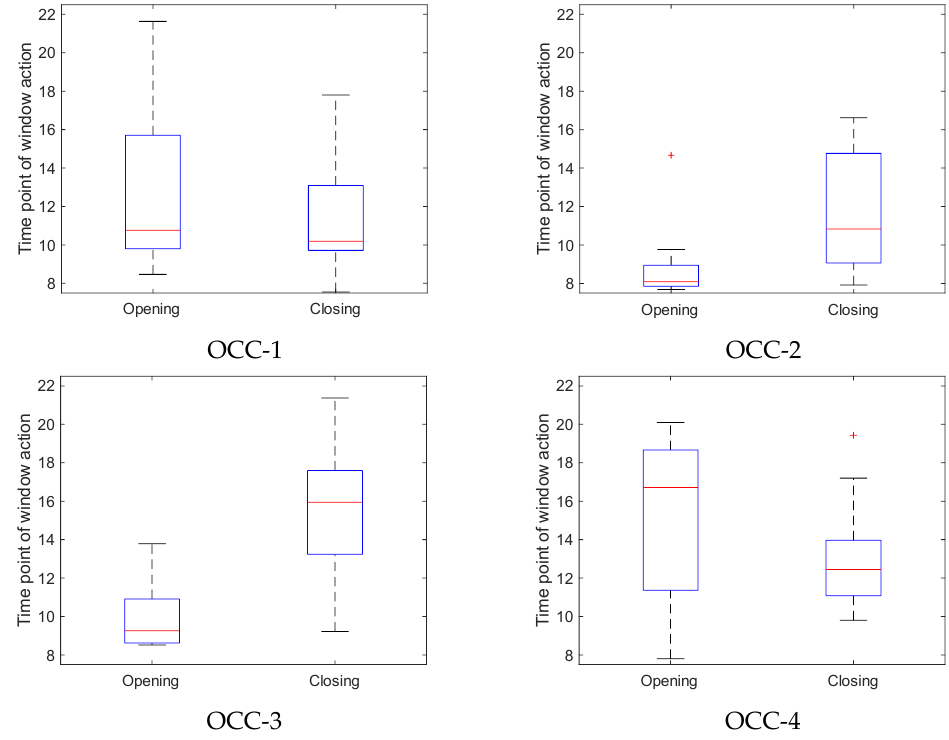
Figure 3. The time at which the window is opened and closed.